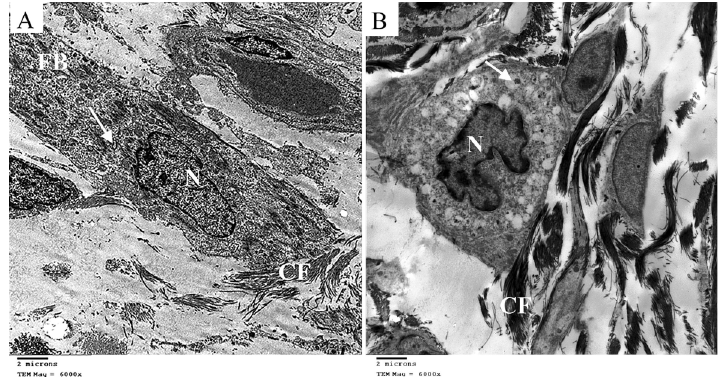
Figure 7. Electron micrographs of fi broblasts in the dermis of neonate rabbits ( (cid:1) 6000, scale bar 2 m m). A , Control group showing dermal fi broblast (FB) with elongated nucleus (N) and rough endoplasmic reticulum (arrow) surrounded by collagen fi bers (CF). B , Constant light group showing dermal fi broblast having folded nucleus with prominent nucleolus (N) and dilated cisternae of rough endoplasmic reticulum with electron dense material (arrow) surrounded by electron dense collagen fi bers